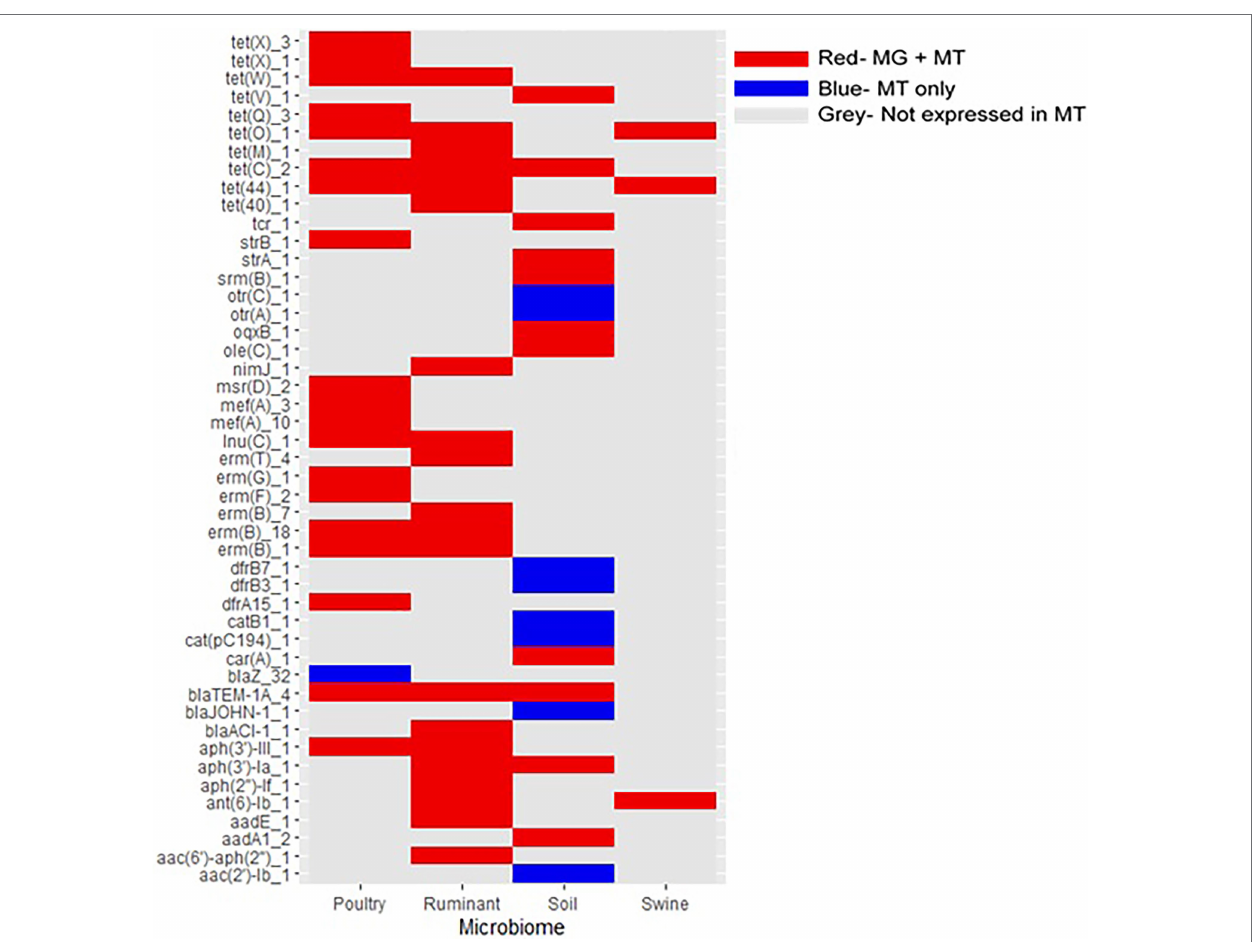
FIGURE 7 | Expression of antimicrobial resistance genes in livestock and soil microbiomes. Only ARGs expressed in at least one metatranscriptome are included. MT, metatranscriptomes and MG, metagenomes. Red gene was present in both the metagenome and metatranscriptome datasets. Blue gene was present in the metatranscriptome dataset only. Gray gene was not present in metatranscriptomic